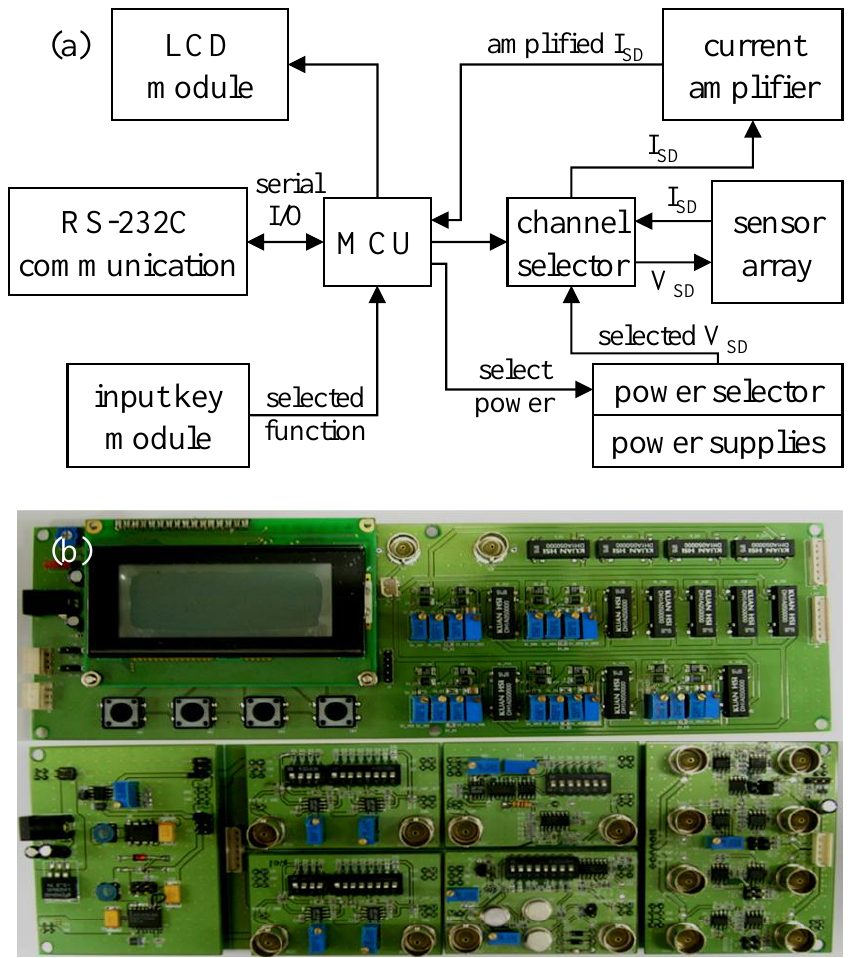
Figure 2. The signal amplification and processing circuits (SAPC); ( a ) block diagram and ( b ) circuit boards (250 × 80 mm 2